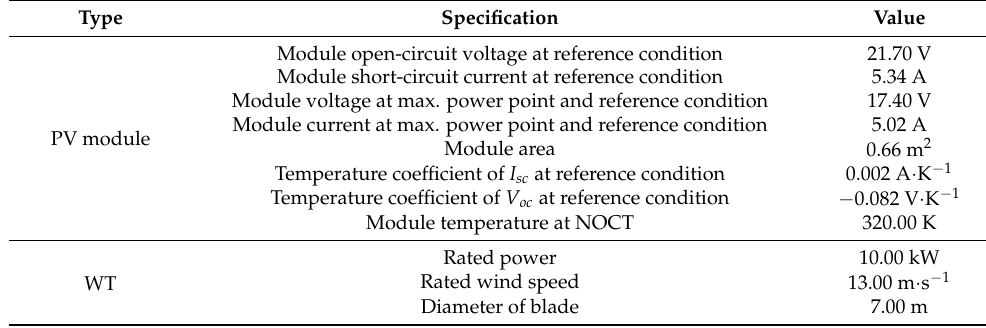
Table 7. Specifications of PV module and WT in model verification.